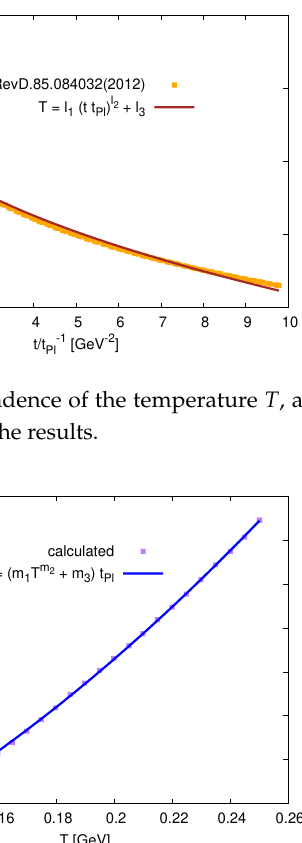
Figure 9. The temperature dependence of the Hubble parameter H , Equation (4). The solid curve represents Equation (26).